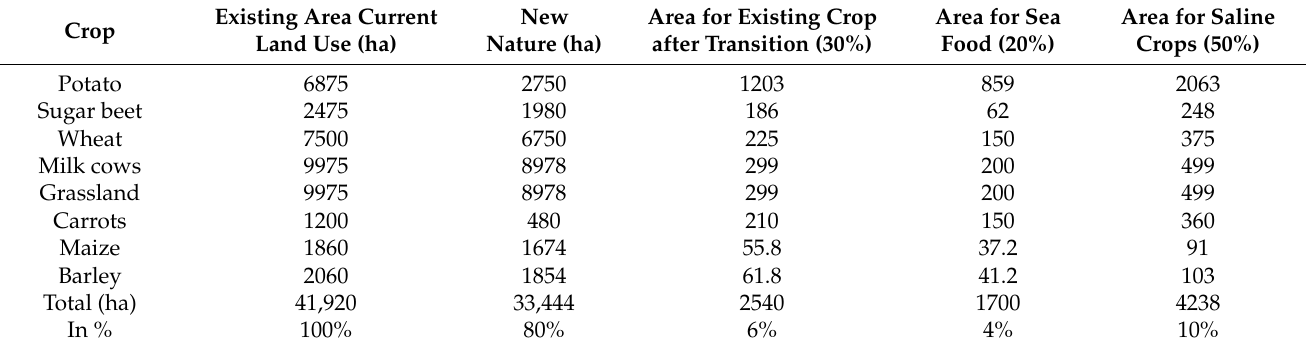
Table 3. Recalculated area for existing and saline produce needed to earn similar